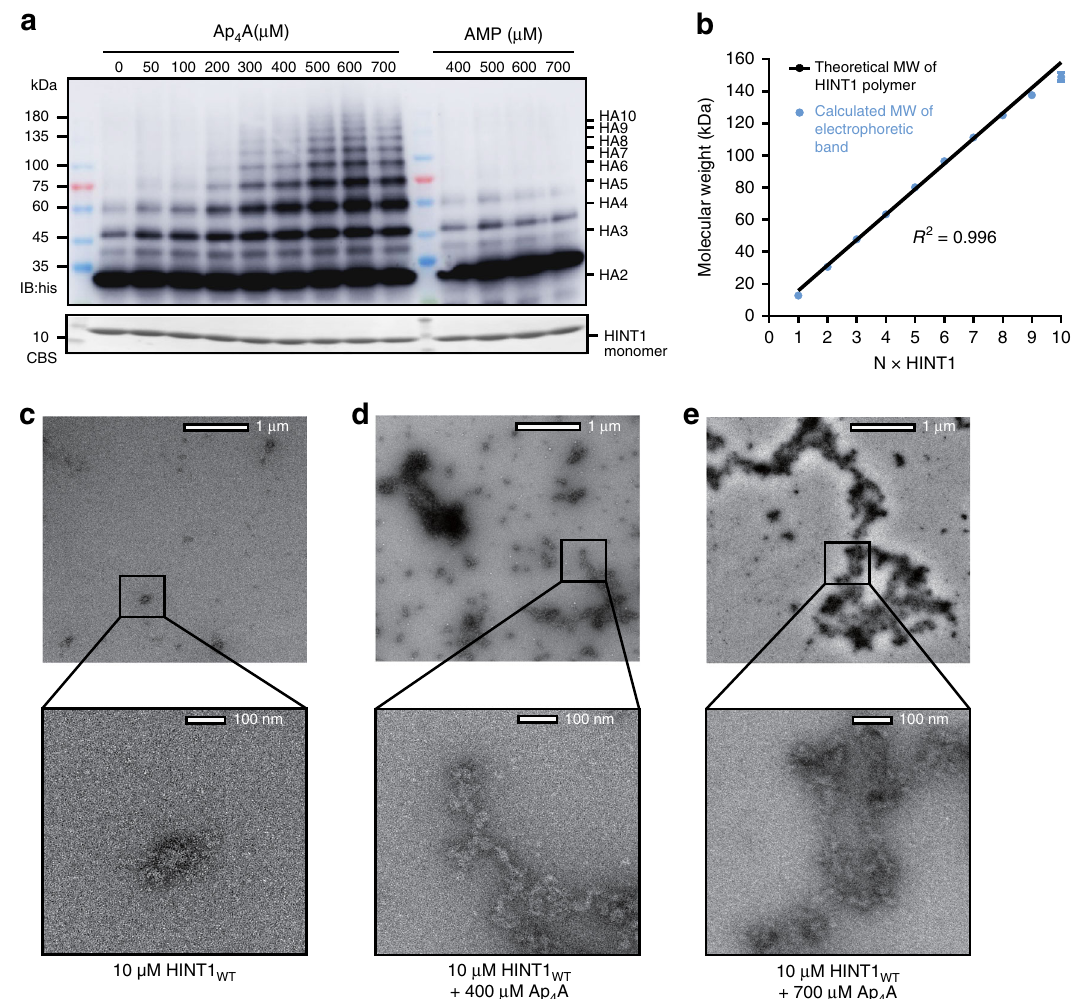
Fig. 2 Ap 4 A-promoted HINT1 polymerization. a Electrophoretic mobility shift assay (EMSA) was performed with 25 μ M HINT1 H114A incubated with 0 – 700 – 700 μ M AMP. The monomer band of HINT1 was detected by Coomassie brilliant blue staining (CBS) and the polymer bands were μ M Ap 4 A or 400 detected by western blotting against the 6×his-tag fused with HINT1. The experiment was performed three times with similar results. Source data are provided as a Source Data fi le. b The molecular weights of the experimental polymers correlated with the integral multiples of the theoretical molecular weight of HINT1 with R-squared = 0.996 (error bars represent the SEM of three experimental repeats). Source data are provided as a Source Data fi le. c – e Negative stain EM images of HINT1 WT without Ap 4 A c , in the presence of 400 μ M Ap 4 A d , or 700 μ M Ap 4 A